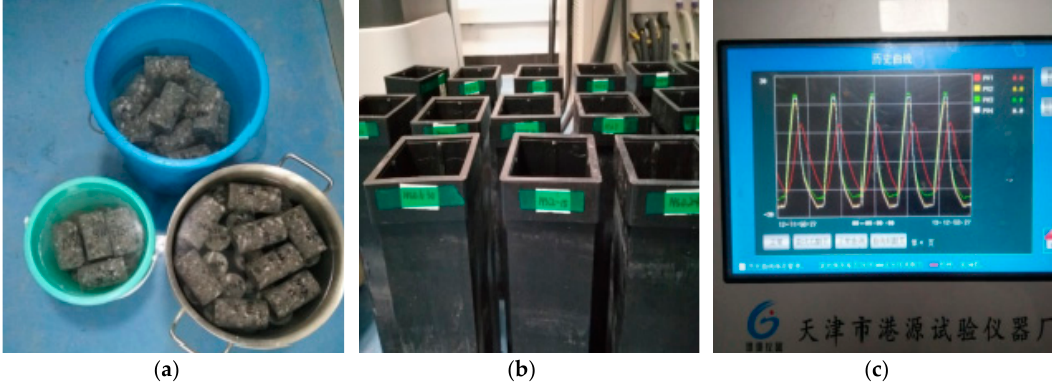
Figure 1. The procedures of freezing and thawing cycles test. ( a ) Test simple soaking; ( b ) Sample box marking; ( c ) Temperature of freeze thaw setup.